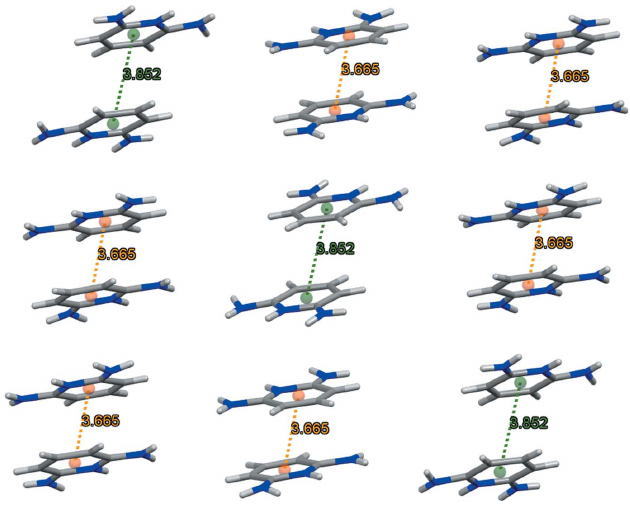
Figure 4 (cid:2) – (cid:2) stacking interactions (orange and green dashed lines) between adjacent 2,6-diaminopyridinium organic